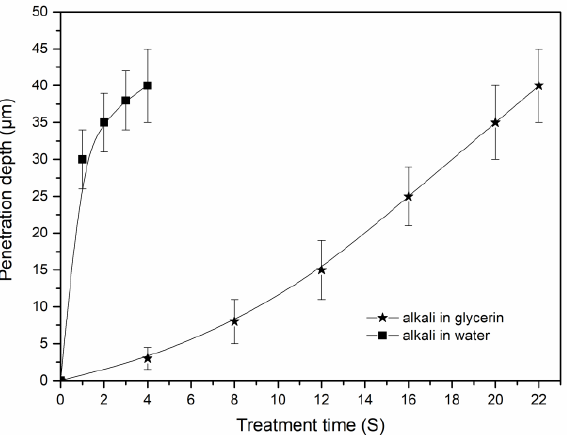
Figure 7. Penetration of alkali into the cotton stalk fibers within the glycerin and water solvents. The average diameter of the raw fibers is about 80 µm.